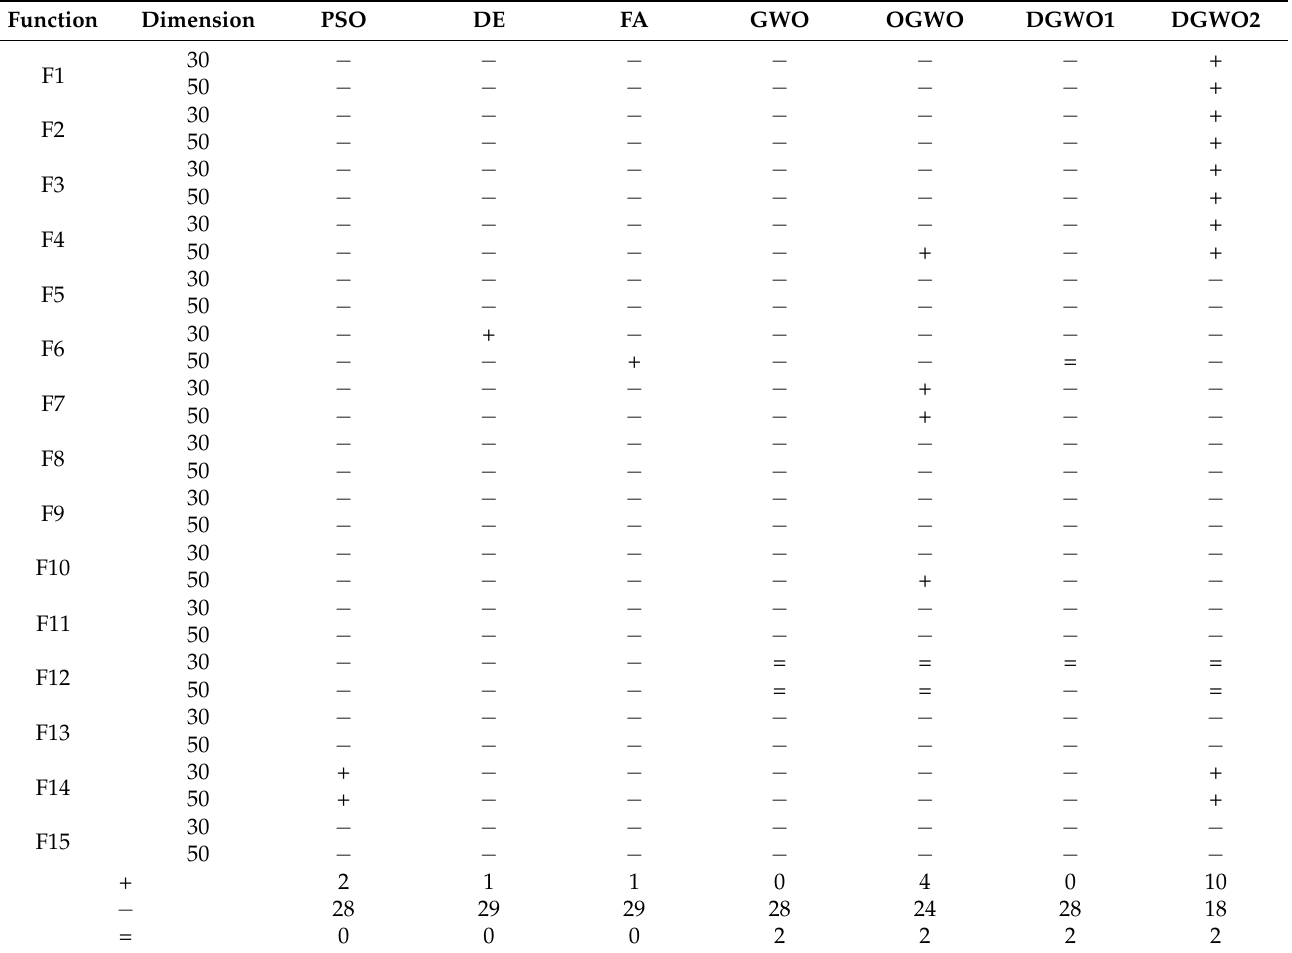
Table 8. The results of the Wilcoxon